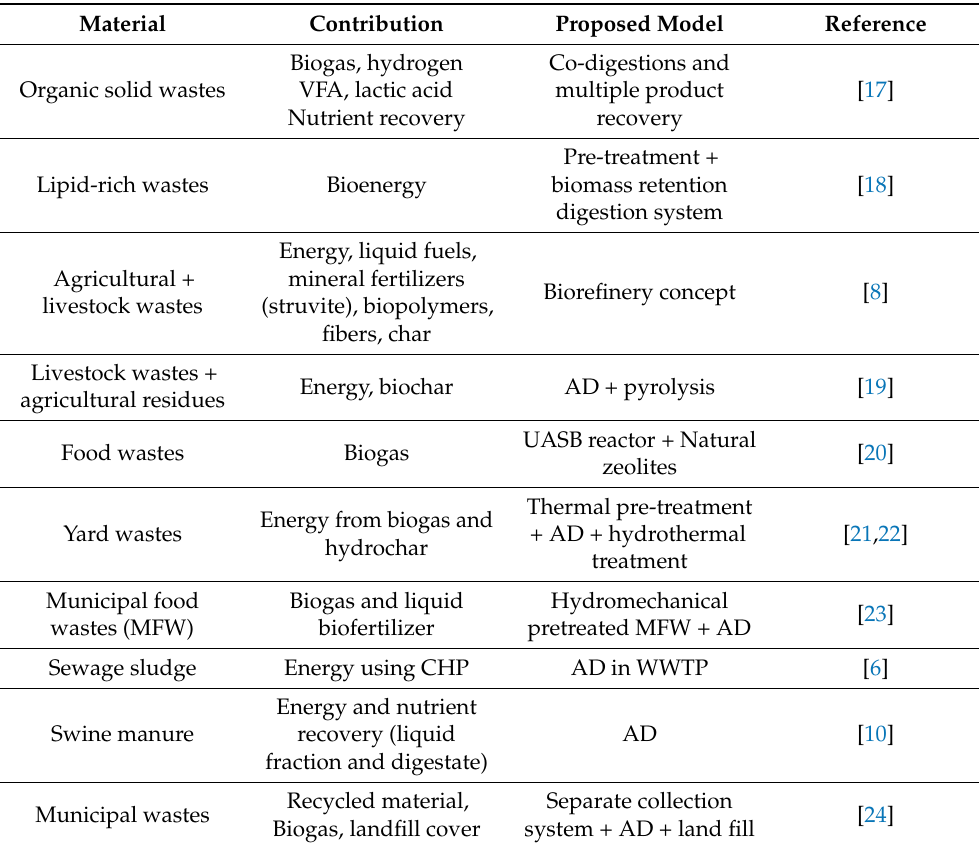
Table 1. The role of anaerobic digestion in the circular economy model. AD: anaerobic digestion, UASB: up-flow anaerobic sludge blanket, WWTP: wastewater treatment plant, CHP: combined heat and